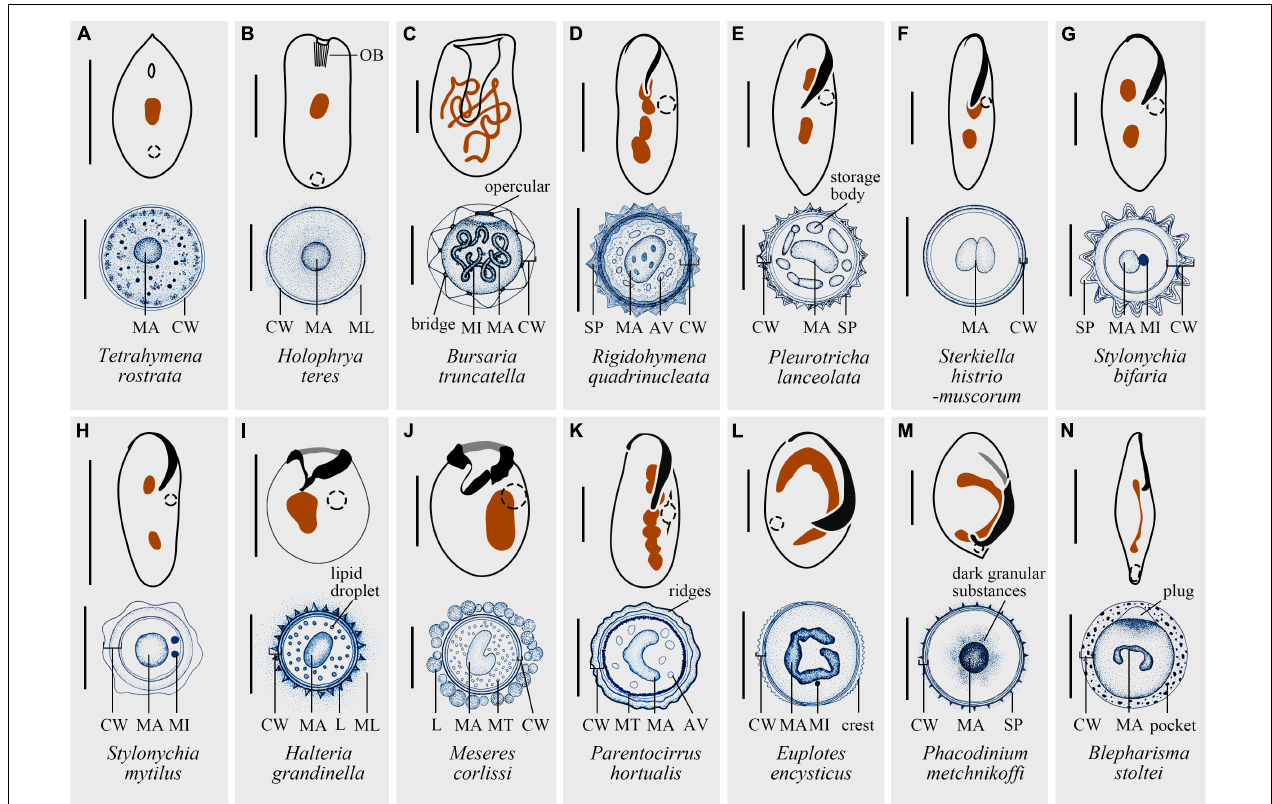
FIGURE 2 | Structure diagrams of resting cysts and vegetative cells of 14 representative species. (A) Tetrahymena rostrata , modified after Stout (1954) and Zebrun et al. (1967). (B) Holophrya teres , modified after Benˇcat’ová et al. (2020) and Foissner (2021). (C) Bursaria truncatella : bridge, between the inner and outer cyst walls; opercular, upon emergence pore; modified after Beers (1948) and Krause and Braucker (2009). (D) Rigidohymena quadrinucleata , modified after Benˇcat’ová and Tirjaková (2017) and Wang J. et al. (2017). (E) Pleurotricha lanceolata : storage bodies, discontinuous ring of hyaline “lakes” in protoplast; modified after Manwell (1928), Jeffries (1956), Jeffries and Mellott (1968), and Dragesco (1972). (F) Sterkiella histriomuscorum , modified after Adl and Berger (1997), Grisvard et al. (2008) and Jiang et al. (2013). (G) Stylonychia bifaria , modified after Ricci et al. (1985), Wirnsberger et al. (1985) and Verni and Rosati (2011). (H) Stylonychia mytilus , modified after Jones (1974), Walker et al. (1975) and Zhang and Pang (1981). (I) Halteria grandinella , modified after Song (1993) and Foissner et al. (2007). (J) Meseres corlissi , modified after Petz and Foissner (1992) and Foissner et al. (2005). (K) Parentocirrus hortualis : ridges, generated by the whole cyst wall; modified after Voß (1997) and Benˇcat’ová et al. (2016). (L) Euplotes encysticus , modified after Rawlinson and Gates (1985), Gu and Zhang (1992), Gu and Xu (1995) and Fan et al. (2010). (M) Phacodinium metchnikoffi : dark granular substances, assumed to be the reserve products; modified after Fernandez-Galiano and Calvo (1992), de Pablo (2010) and Benˇcat’ová and Tirjaková (2018). (N) Blepharisma stoltei : pockets, intrinsic part of the outer wall and appearing as disk-like structures; modified after Repak and Pfister (1967), Repak (1968) and Chi et al. (2021). MA, macronucleus; CW, cyst wall; OB, oral basket; ML, mucous layer; SP, spines; AV, autophagic vacuoles; L, lepidosomes; MT, mitochondrium. Scale bars: 30 µ m (A,F,G,I,J,L) , 50 µ m (B,D,E,K,M) , 100 µ m (C,H,N)